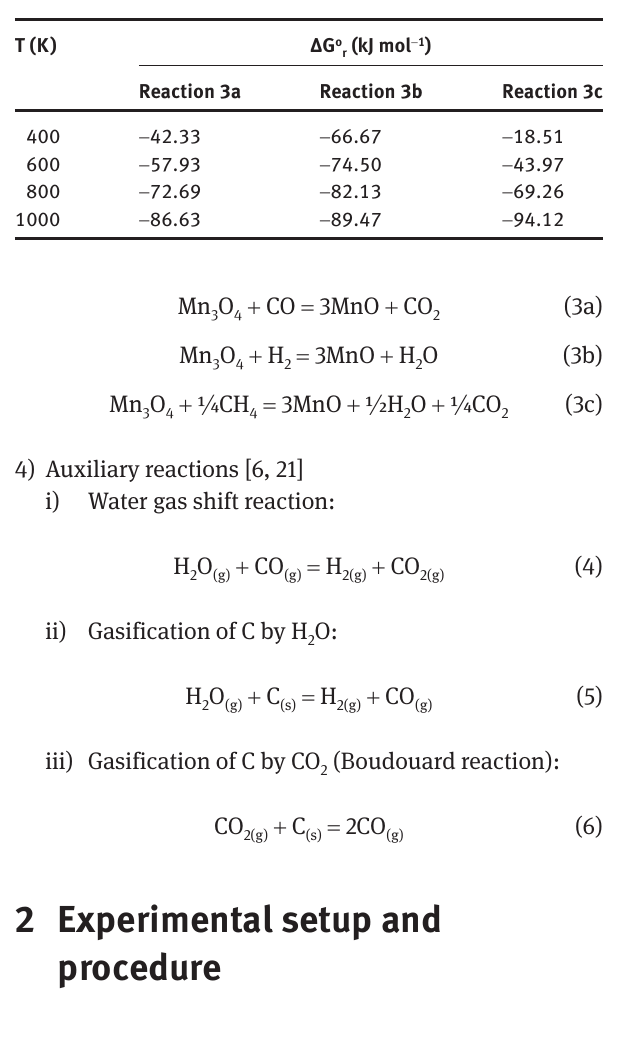
Table 1: Reaction standard Gibbs energy for Mn 3 O 4 reduction [10]